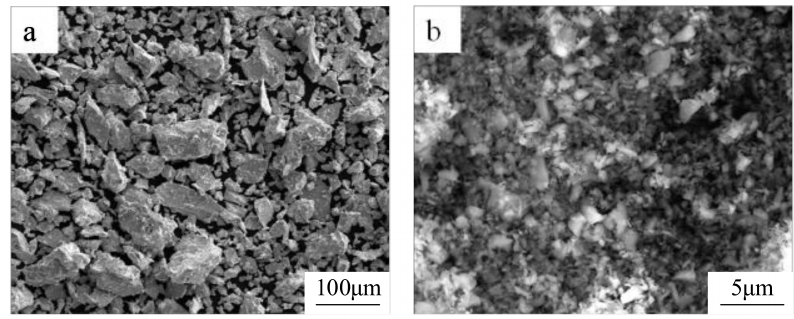
Figure 1. Morphology of original powders: ( a ) original Nb powders; ( b ) original SiC powders. Samples were taken from the sintered materials for property testing and microstructure observation. Actual density was measured according to the Archimedean drainage